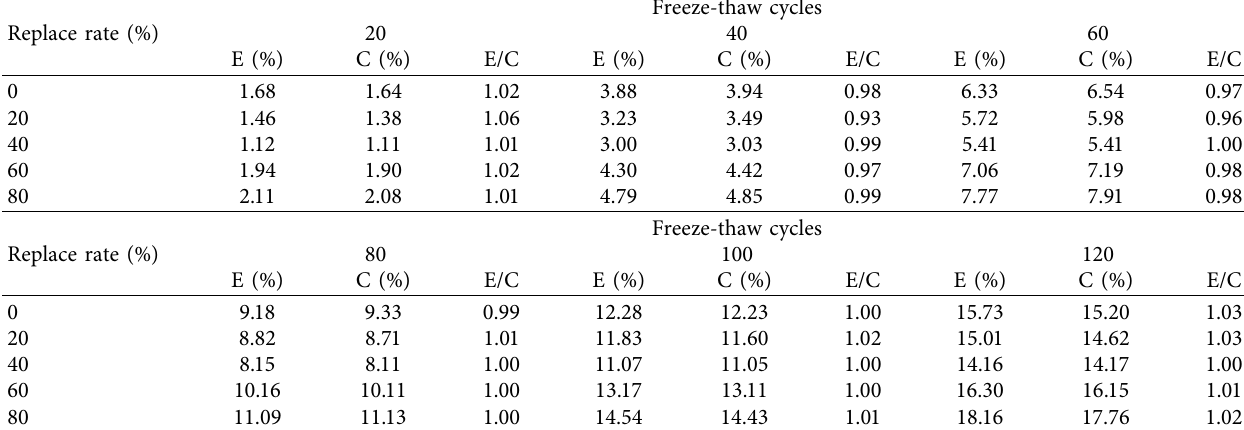
Table 9: The comparison between the calculated value and the experimental value of freeze-thaw damage degree. Replace rate (%)